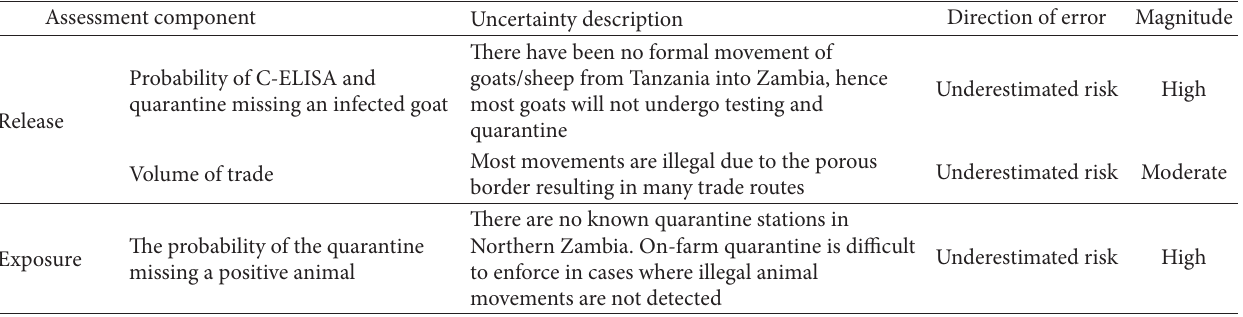
Table 3: Description of model uncertainties.